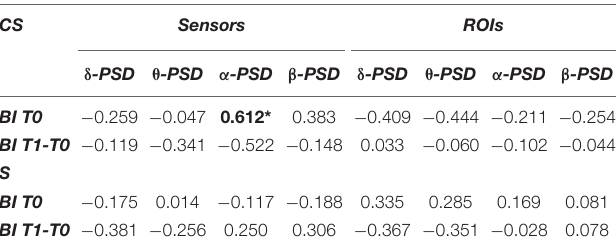
TABLE 2 | Spearman’s correlations between average power of EEG frequency bands of interest and Barthel Index at T0 (BI T0) or Barthel Index variation (BI T1-T0).